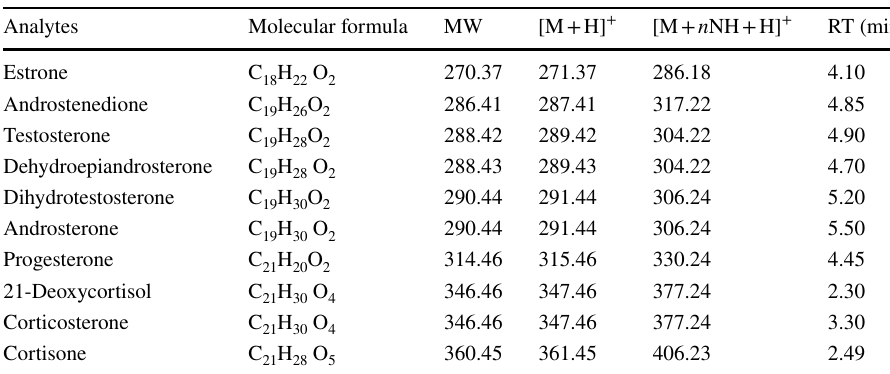
Table 4 Mass spectrometric parameters of the analytes